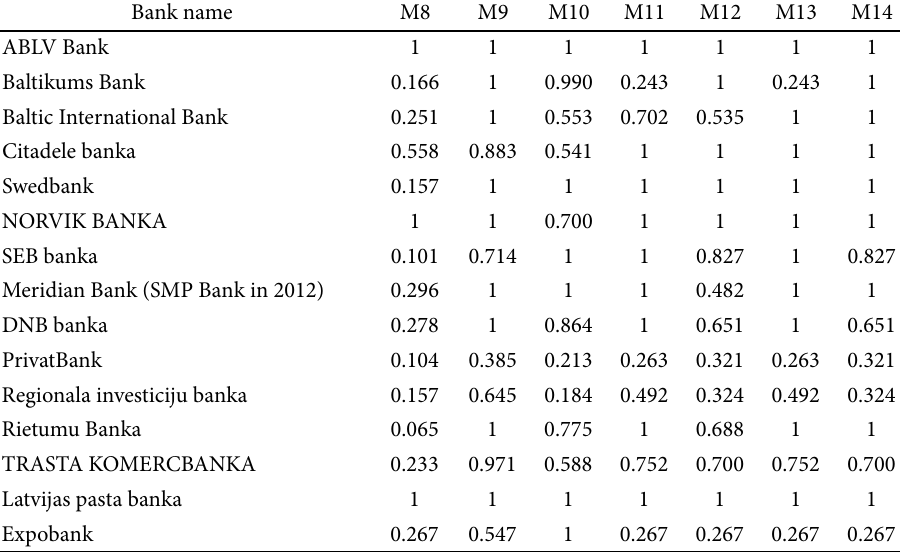
Table 7. Efficiency scores estimated for Latvian banks, using models M8-M14